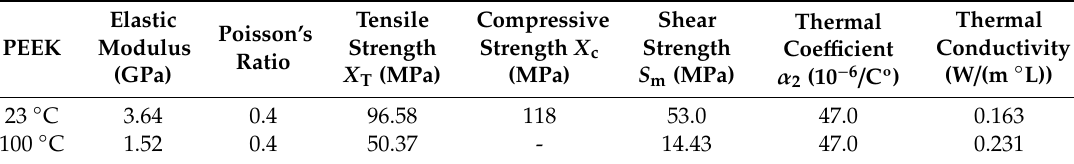
Table 1. Material parameters of PEEK matrix at room temperature and elevated temperature.